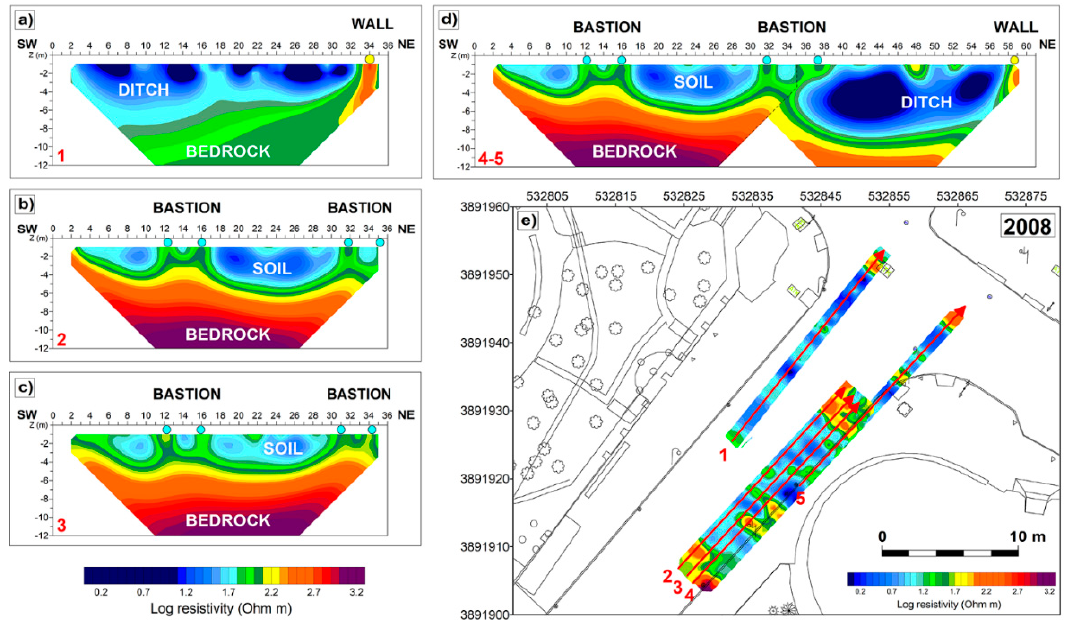
Figure 6. Eleftheria Square: ERT profiles 1–5 ( a – d ) and the modelled horizontal resistivity map relative to 1.2 m in depth ( e ).